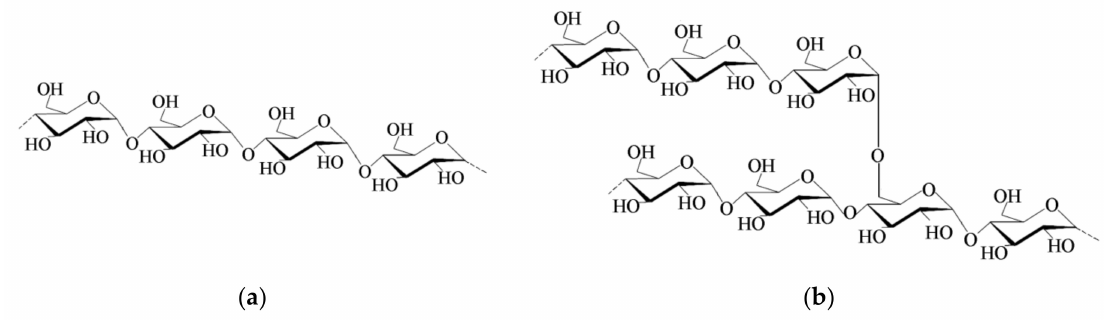
Figure 1. Schematic representation of amylose ( a ) and amylopectin ( b )